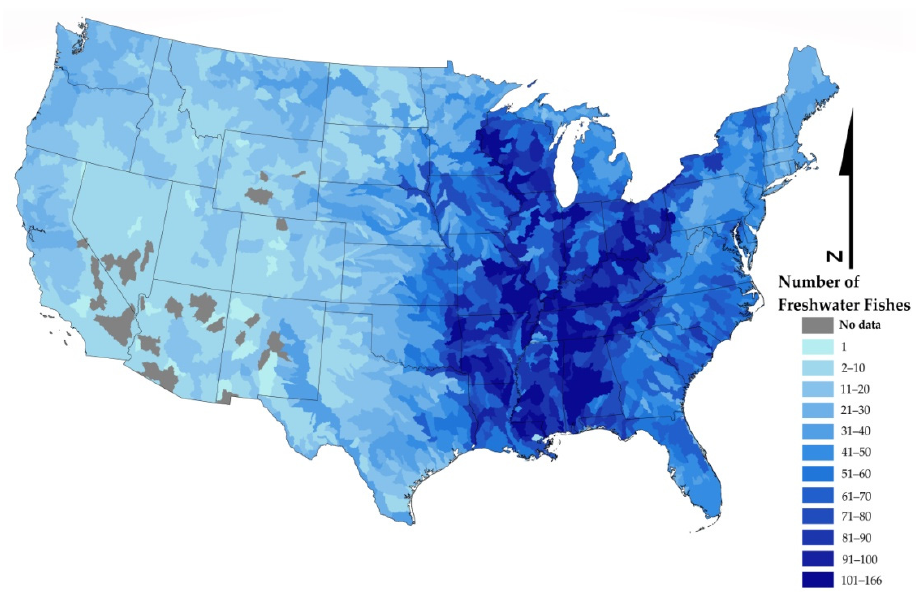
Figure 1. Number of freshwater fish in each HUC8 of the conterminous United States, including watersheds that did not contain information about the presence of freshwater fishes (grey).